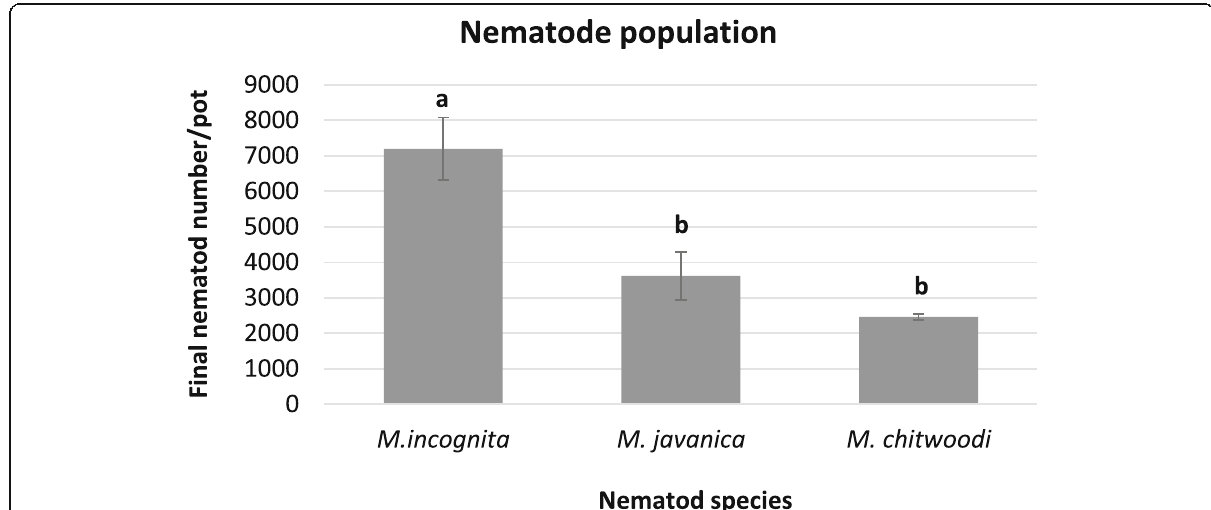
Fig. 1 Nematode population (reproduction) of Meloidogyne species: M. incognita , M. javanica , M. chitwoodi in the roots of tomato plants. Initial nematode number (first infection number) was 1000 nematode in each pot for each plant. Final nematode number was calculated following the 2 months later of nematode inoculation. Randomised block design was accomplished with five repetitions. Y axis represents final nematode number per plant, X axis indicates nematode species. Error bars represents the standard error of the means of five replicates. Letters on the column indicates the statistical differences ( P < 0.05) among nematode populations